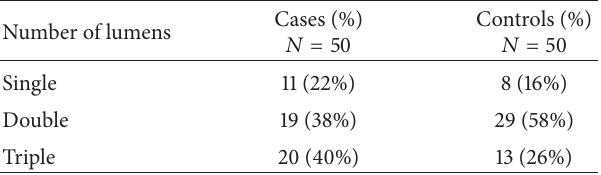
Table 2: Various catheter characteristics based on lumen size.